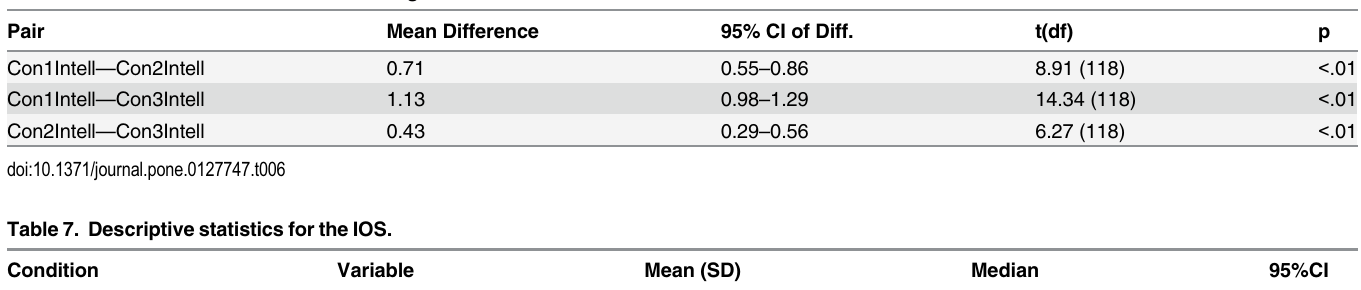
Table 6. Post-hoc tests for Perceived Intelligence.